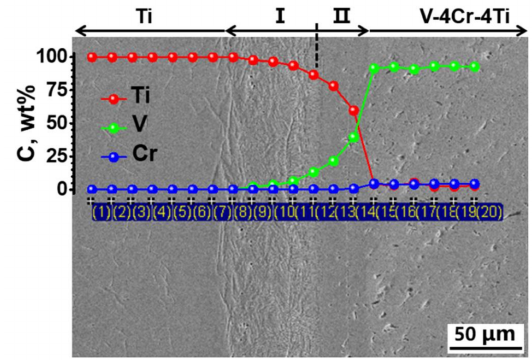
Figure 3. Concentration profiles of Ti, V, and Cr across the chemically etched V–4Cr–4Ti/Ti